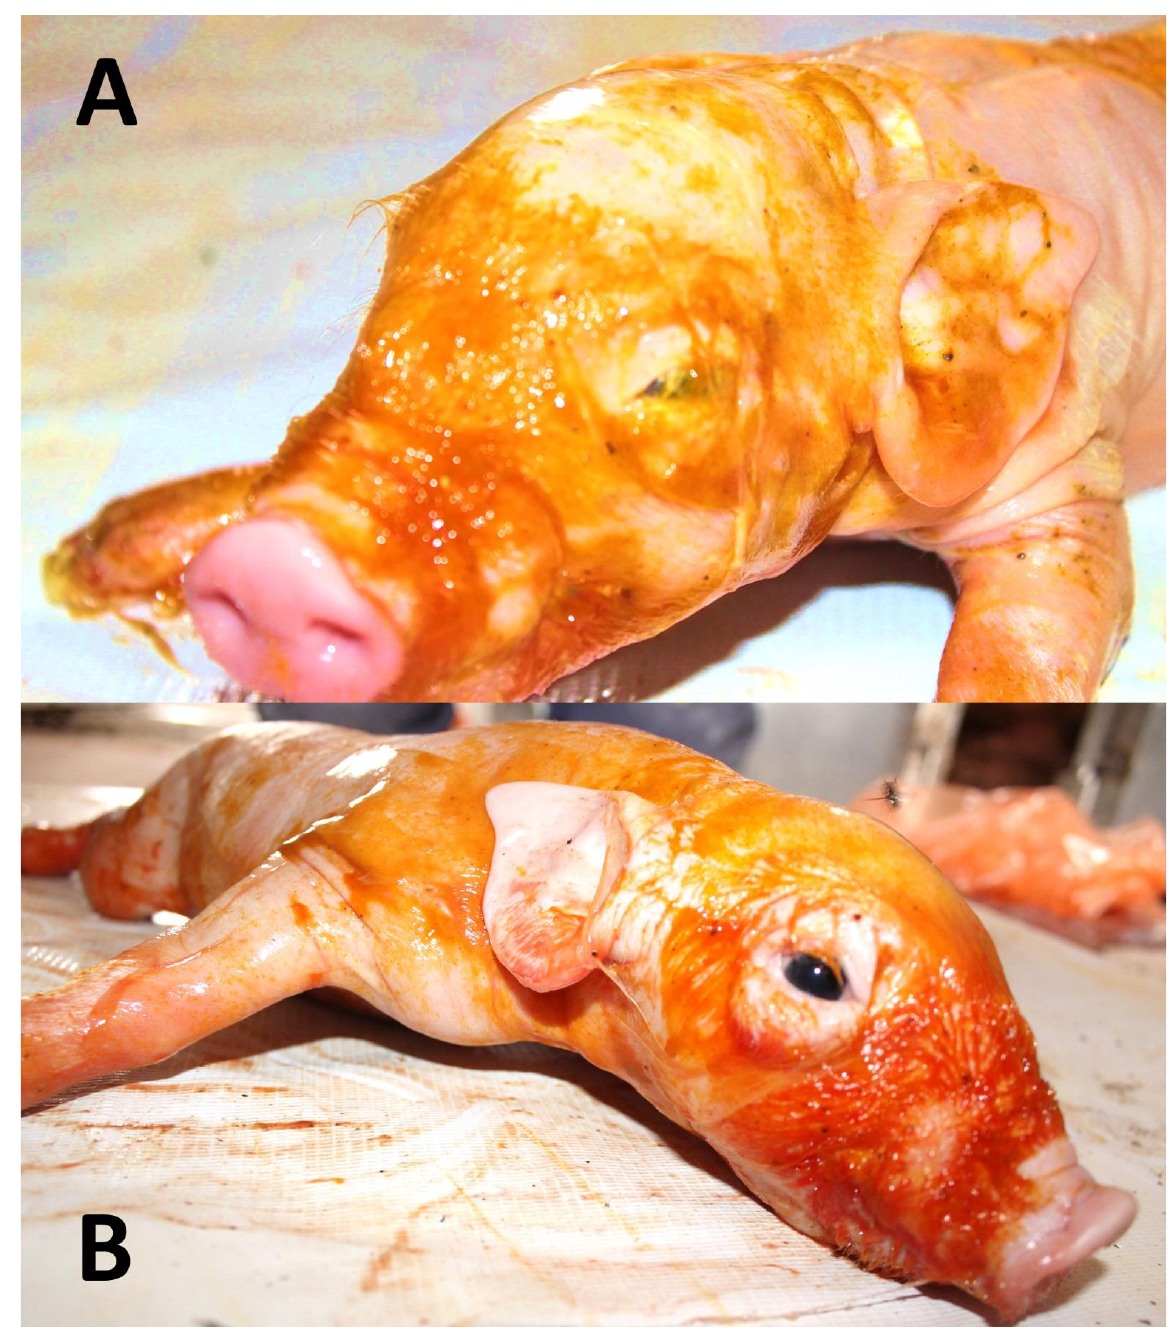
Figure 2. Meconium-stained piglets after dystocia in a primiparous sow. The expulsion interval between neonates was greater than 3 h. Both neonates survived an episode of severe hypoxia. ( A ). The newly born pig was lethargic, adynamic, hypoglycemic, uncoordinated and its vitality score dropped. The newborn was unable to suckle/eat feed as it lost the sucking reflex. It died within the next 24 h. ( B ). Neonate stained with meconium in more than 60% of the body surface. It shows vigor, as it makes attempts to get up despite being weak. After colostrum intake, the piglet survived.